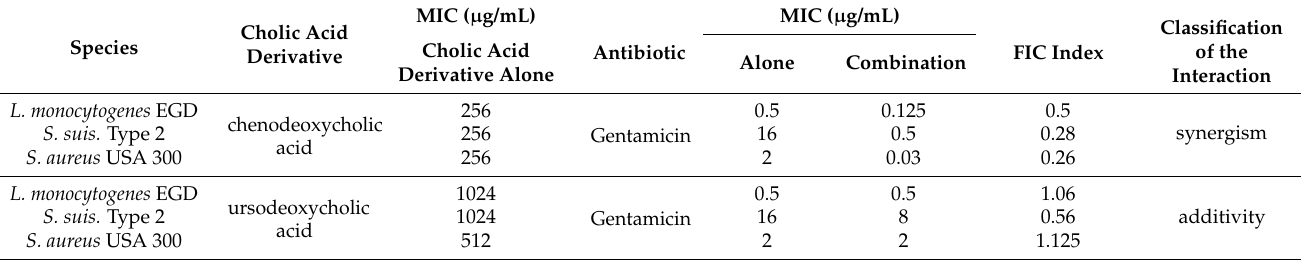
Figure 11. Interaction of LCA derivatives and Genta against L. monocytogenes ( A , D , G , J ), S. suis ( B , E , H , K ) and S. aureus ( C , F , I , L ). Table 3. The MIC and FIC index determination of the cholic acid derivative combined with Genta against Gram-positive bacteria.